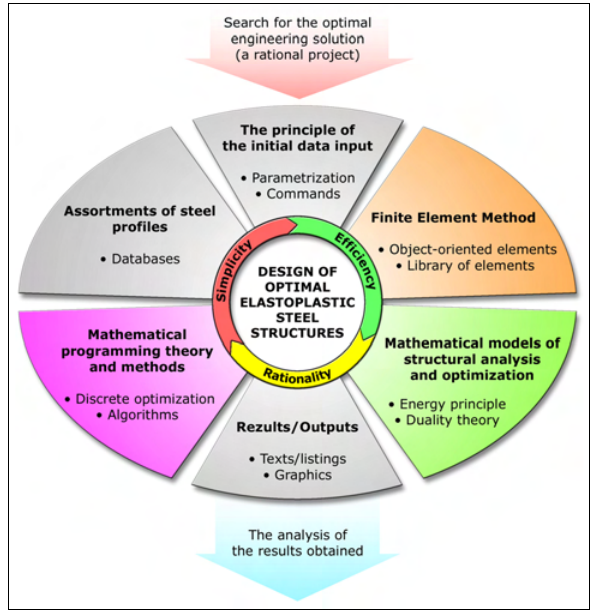
Fig. 1. The main parts of the optimal design system of